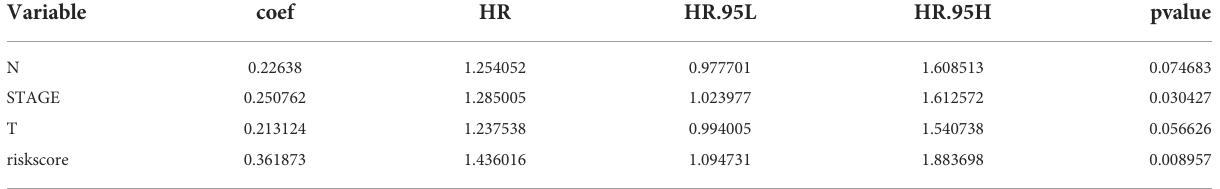
TABLE 9 Prognostic factors associated with LUAD were detected by multivariate Cox regression analysis in the GSE50018 dataset.